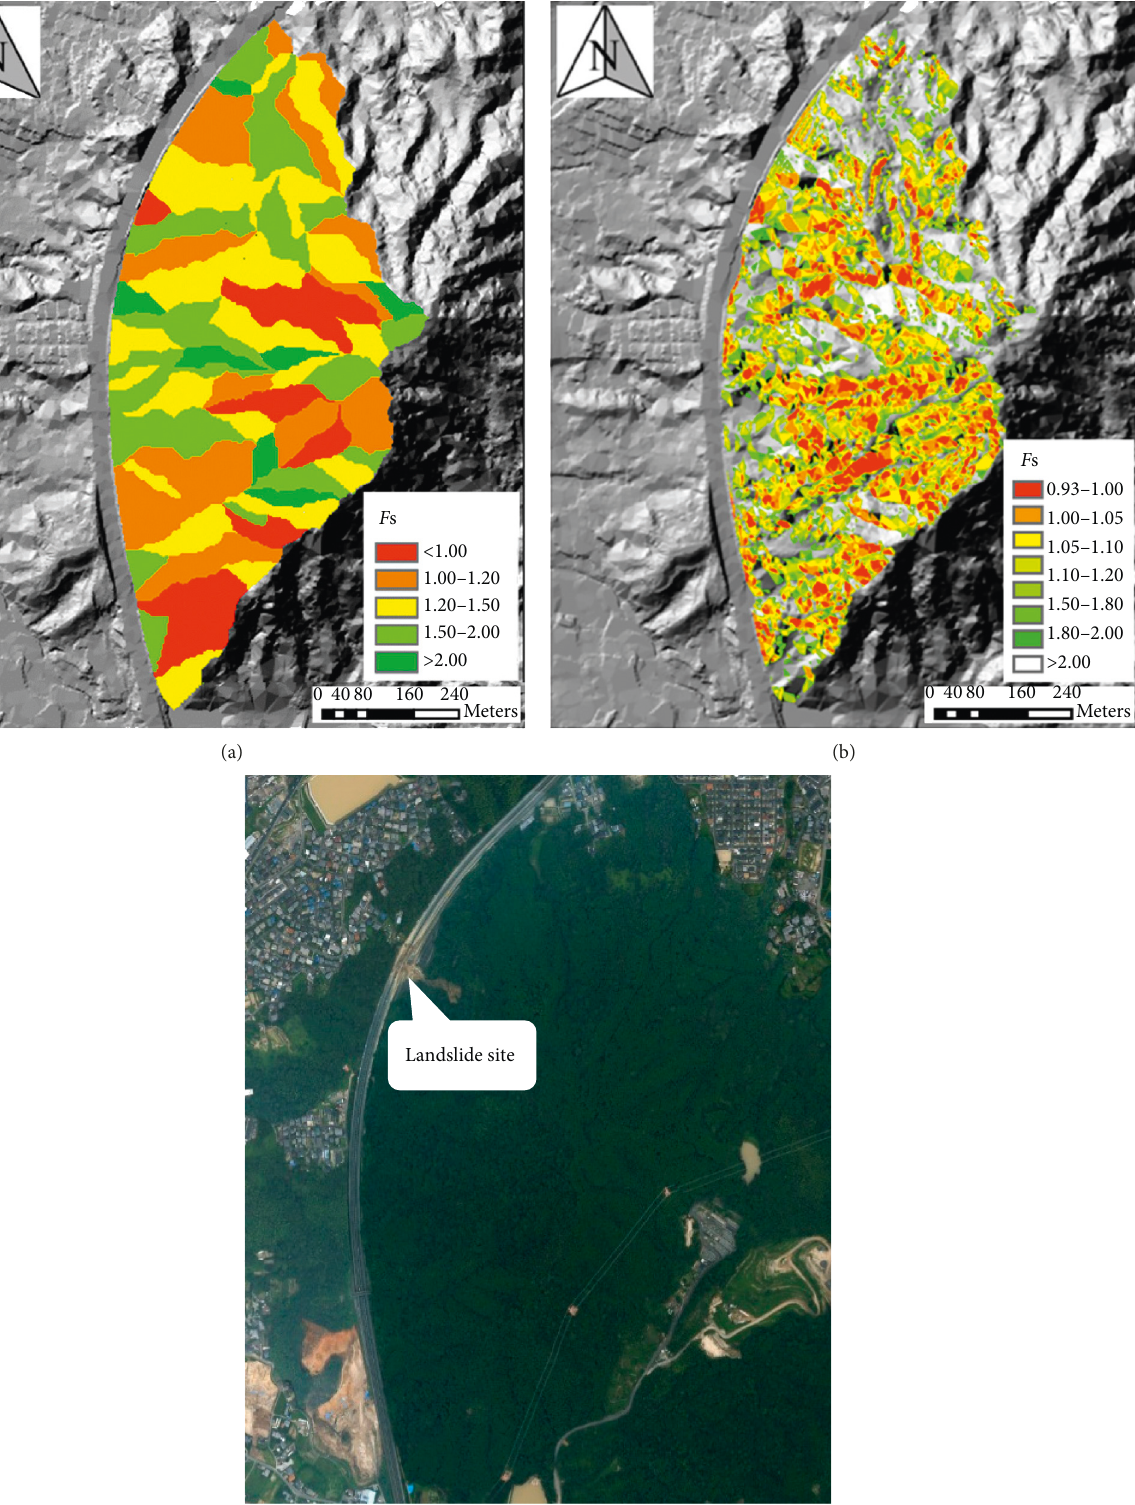
Figure 11: Maps of regional slope stability: (a) integral sliding; (b) planar sliding; (c) landslide